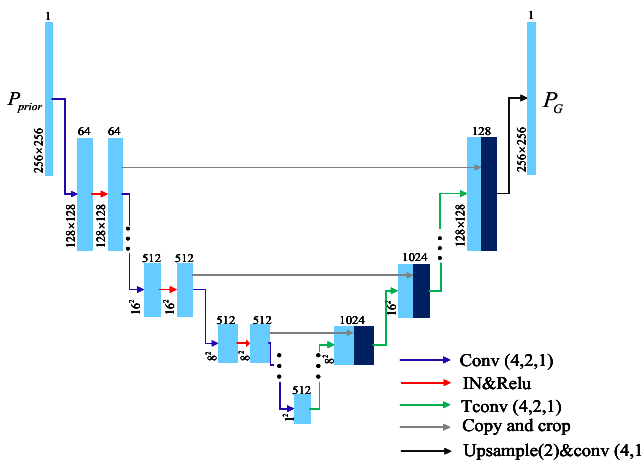
Figure 6. Detailed structure of the generator network module. The conv ( m , n , q ) and Tconv ( m , n , q ) , respectively, denote the convolution operation and the de-convolution operation, where the size of the convolution kernel is set as m ∗ m , the stride is set as n , and the padding is set as q ; IN represents the instance norm layer, and upsample ( 2 ) represents the network layer with an upsampling factor of